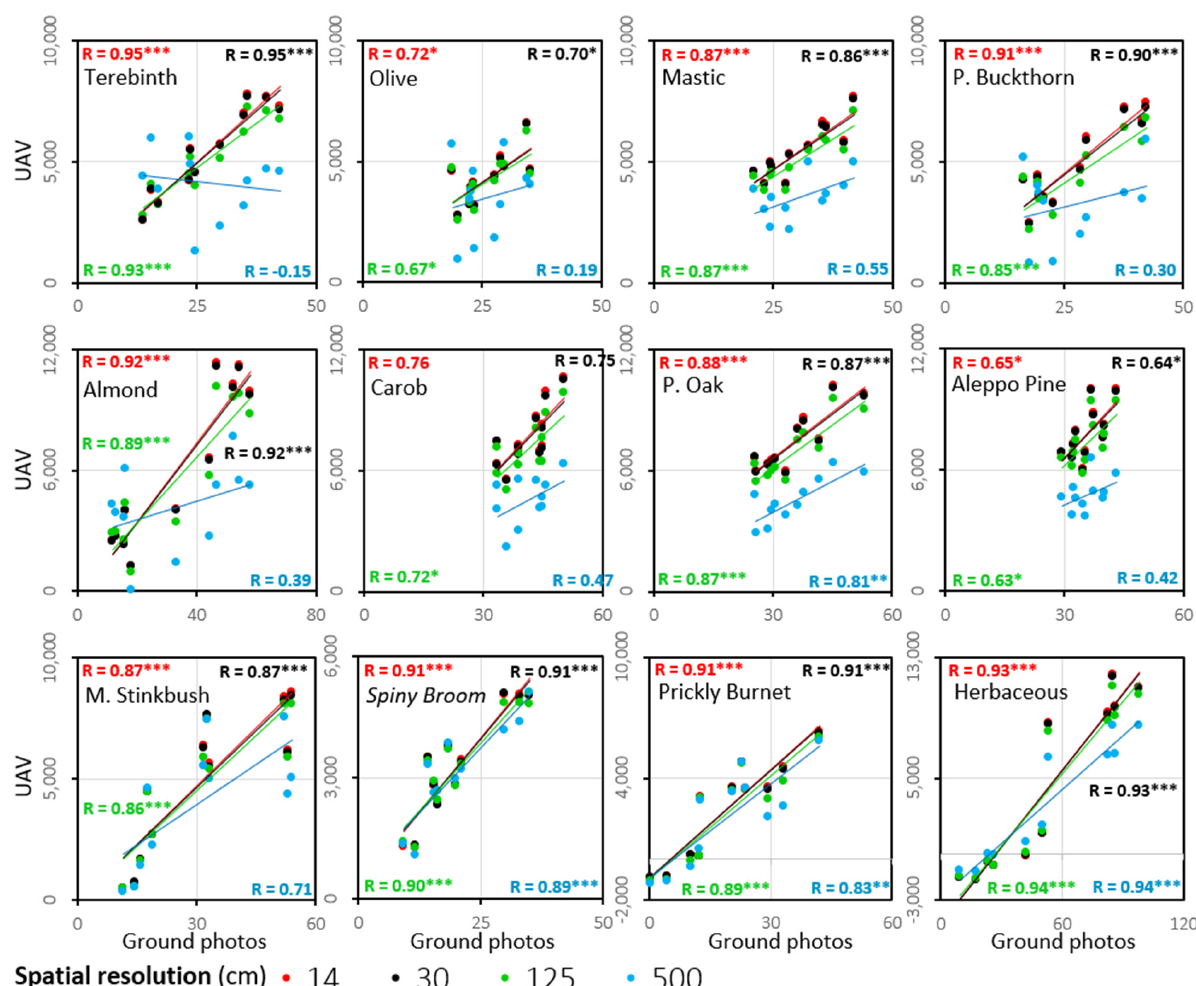
Figure 8. Standardized mean ExG values for the 12 species based on the UAV data (11 dates) after resampling to spatial resolutions of 14, 30, 125, and 500 cm. The y -axis represents the index mean value as a percent of the range of the possible values for each sensor.